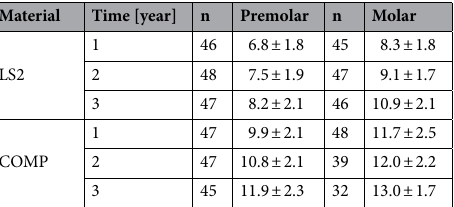
Table 1. Mean values ± standard deviation (µm) of superimposition error between baseline und follow-up